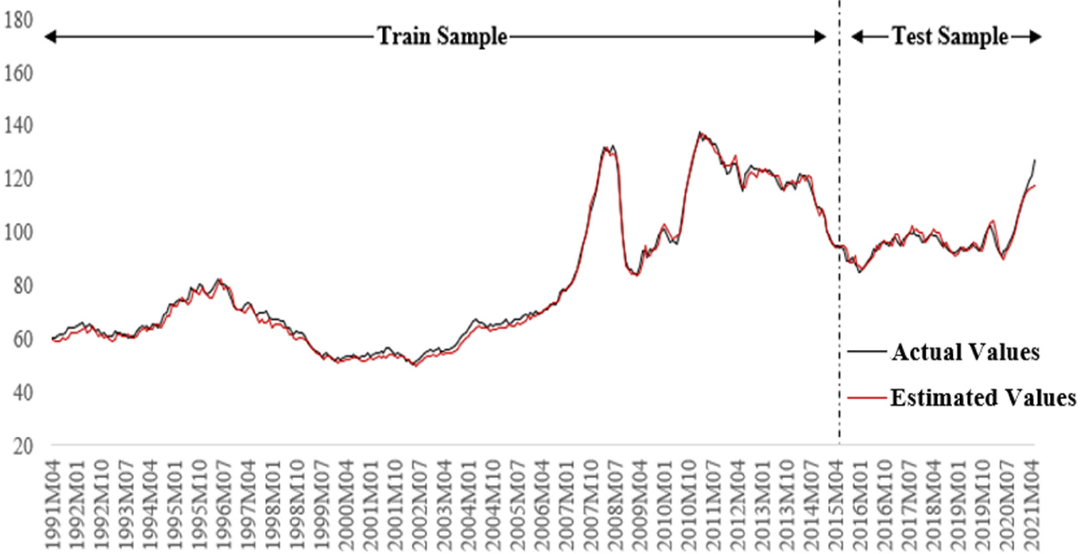
Figure 5. Actual and estimated values of the global food prices.